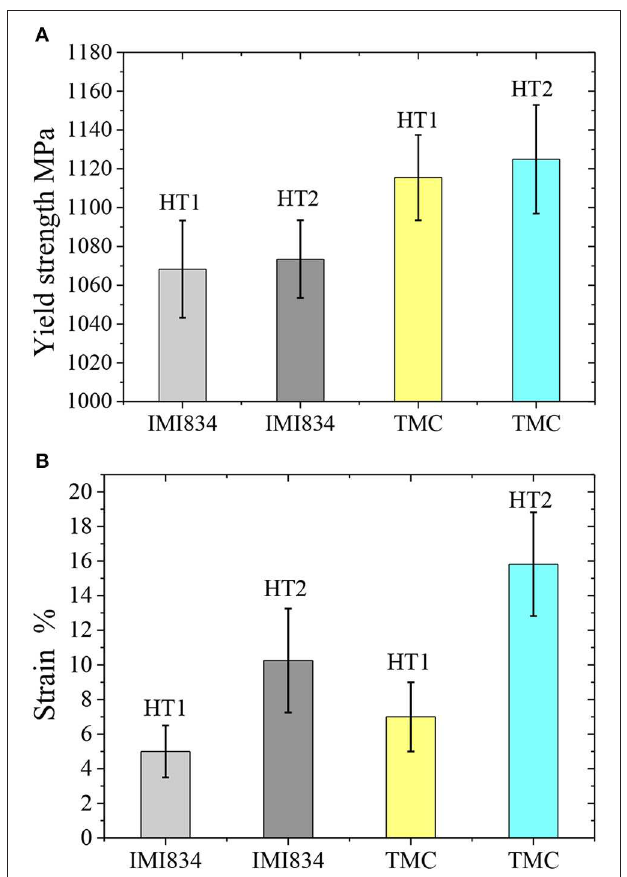
FIGURE 4 | Room temperature tensile properties of heat treatment of matrix alloy and TMCs. (A) Yield strength. (B) Elongation.